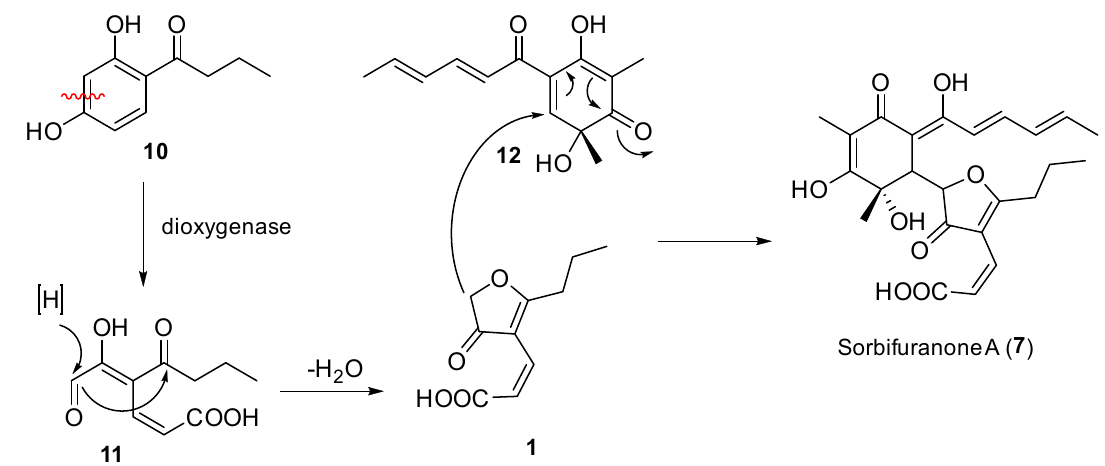
Figure 5. Antimicrobial activity of 5 against M. abscessus and M. marinum. The raw data (Supplementary Materials II) has been deposited online on Figshare.com (doi:10.17608/k6.auckland.14503584).